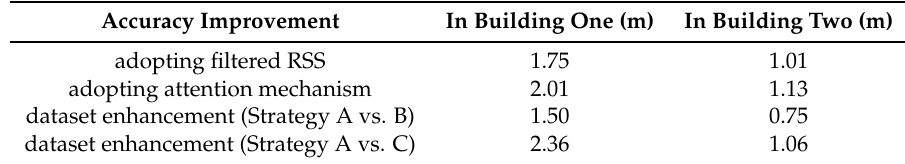
Figure 13. The CDF comparison between adopting different dataset enhancement strategies in ( a ) Building One and ( b ) Building Two. Table 1. Summary of the positioning accuracy enhancement adopting the filtered RSS, attention mechanism and dataset